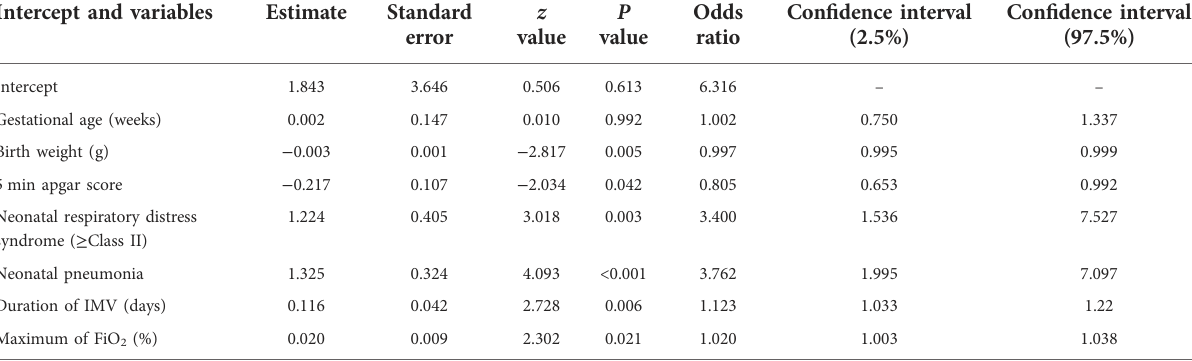
TABLE 2 Logistic regression analysis of the predictors for the risk of moderate and severe bronchopulmonary dysplasia (BPD) in infants with gestational age <30 weeks and birth weight <1,500 g on postnatal Day 14. Intercept and